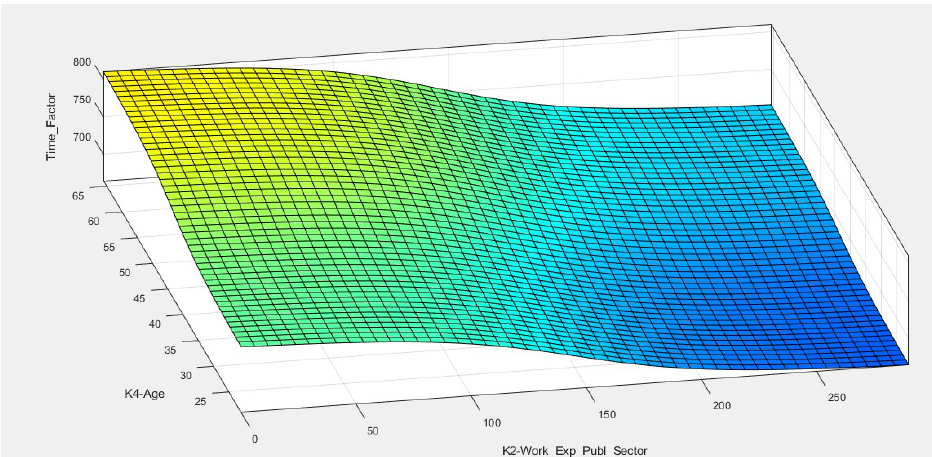
Figure 10. Results of work experience in public sector and age.